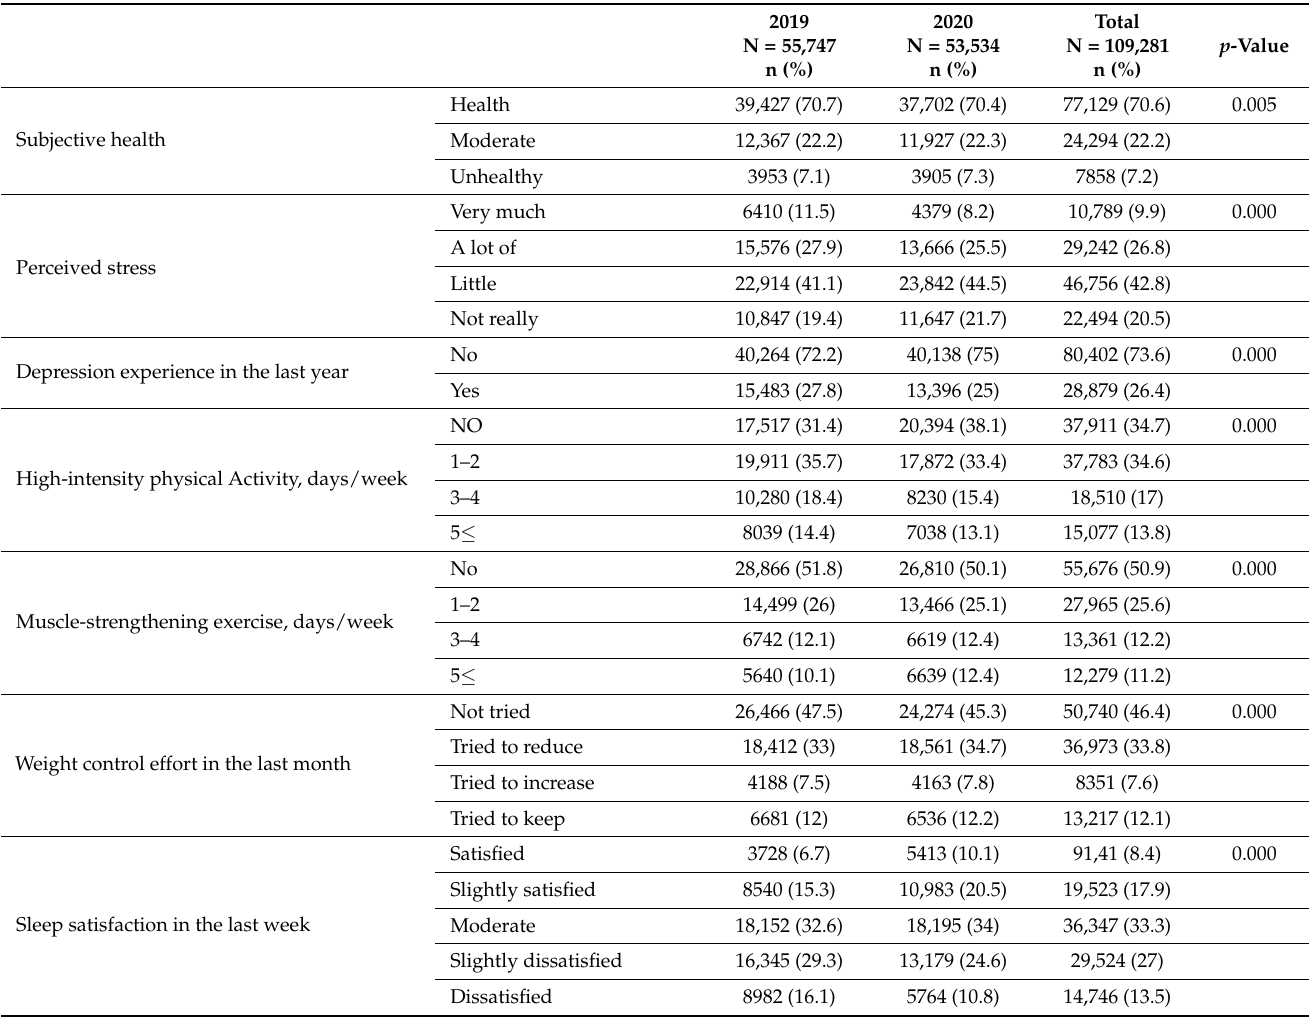
Table 2. Participants’ mental state and physical